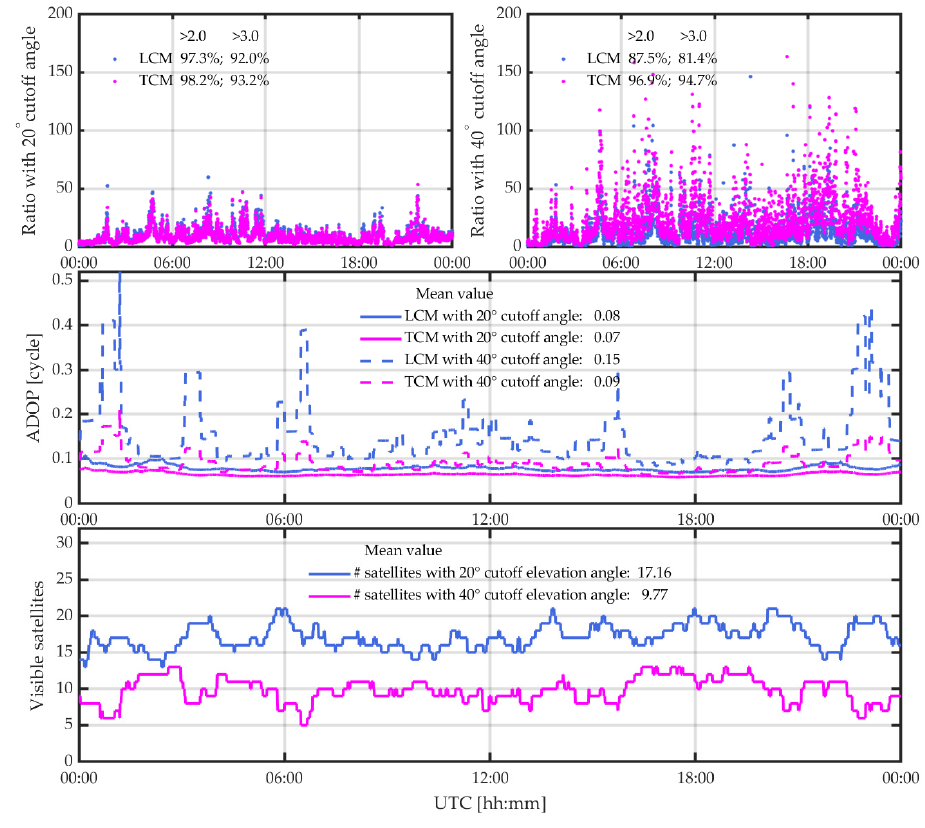
Figure 9. Time series of ratio ( top ), ambiguity dilution of precision (ADOP) ( middle ), and number of visible satellites ( bottom ) of LCM and TCM RTK of baseline GODE-USN7 on DOY 120, 2021 with cutoff elevation angles of 20 and 40°. The blue and magenta indicate LCM and TCM, respectively.